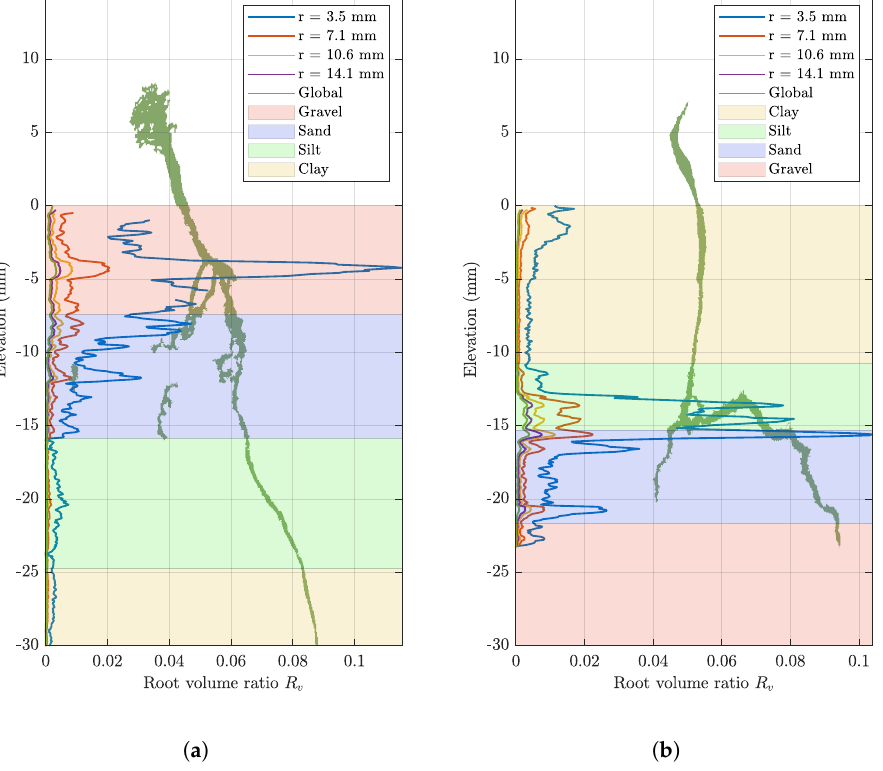
Figure 7. Root volume ratio profiles with elevation of ( a ) sample A, day 15 and ( b ) sample B, day 15, using the 10% classifier (the layer thickness corresponds to averaged elevation for each